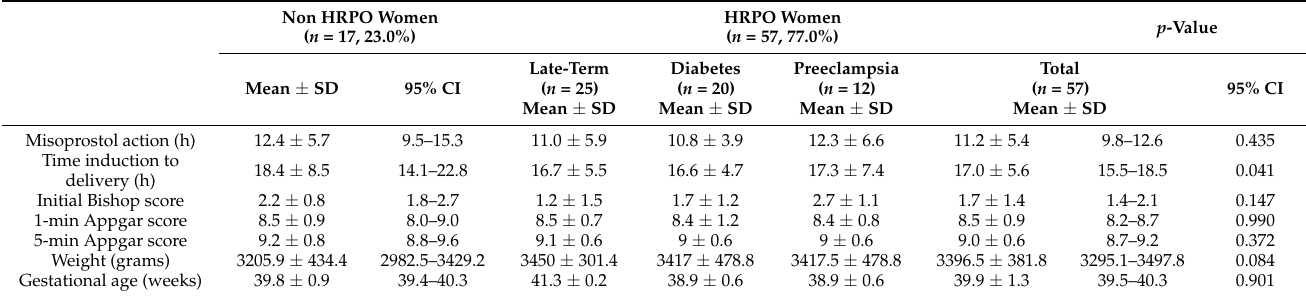
Table 4. Outcomes of the MVI IOL in the studied group by type of risk factor.